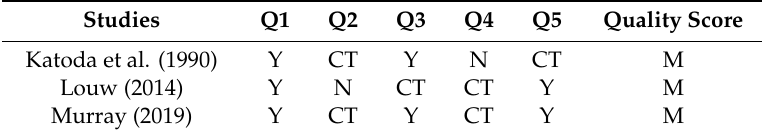
Table 2. Methodological quality of quantitative studies using (MMAT) (Hong et al.,